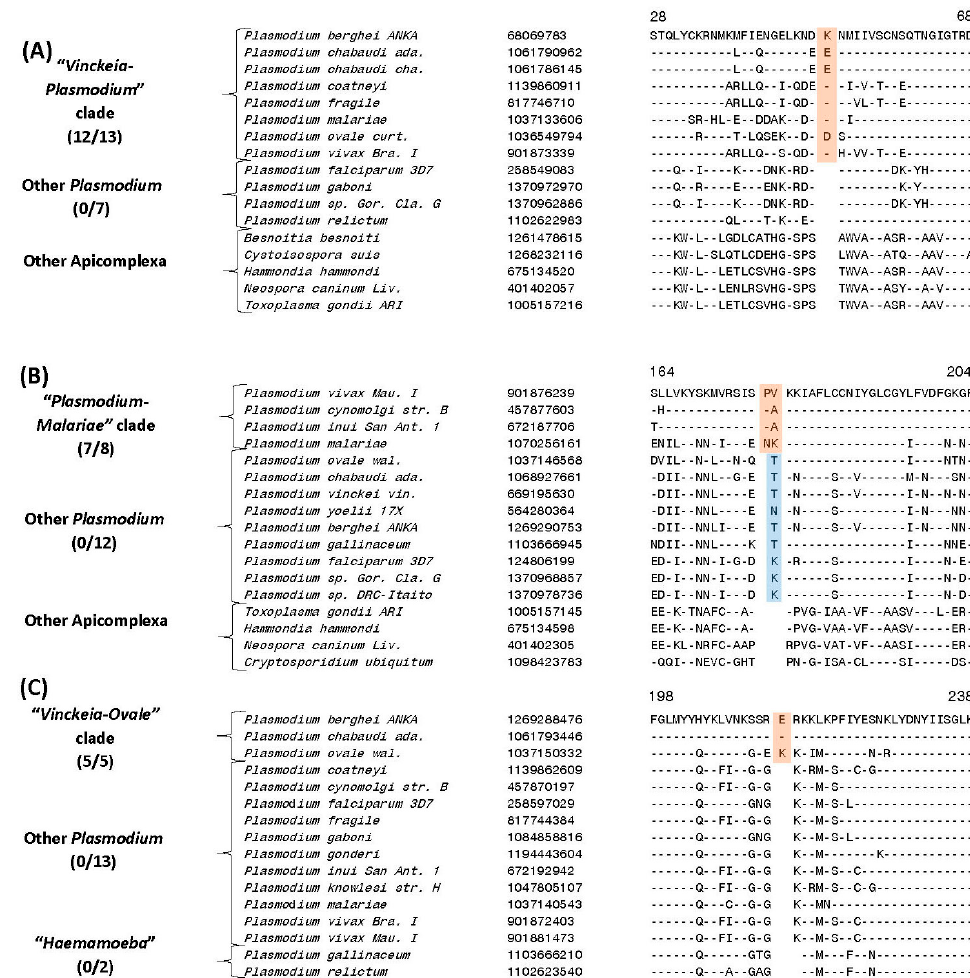
Figure 6. Examples of CSIs specific for the mammalian Plasmodium groups clarifying the genetic association of P. ovale and P. malariae species ( A ) Partial sequence alignment of the protein biotin-acetyl-CoA-carboxylase ligase showing a 1-aa insertion that is exclusively shared by all species from the subgenera Plasmodium and Vinckeia . ( B ) Partial sequence alignment of the ubiquitin-activating enzyme E1 protein showing a 2-aa insertion that is uniquely shared by di ff erent members of the subgenus Plasmodium but lacking in P. ovale . P. knowlesi contains a three aa insert in this position (not shown). ( C ) Partial sequence alignment of the phosphoinositide-specific phospholipase C protein showing a 1-aa insertion which is exclusively shared by members of the